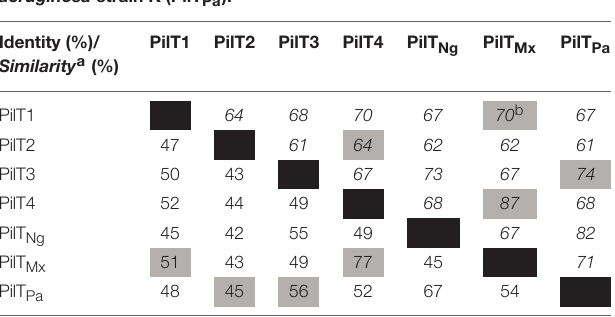
TABLE 3 | Identity and similarity of the putative PilT proteins of G. sulfurreducens (in red) in pairwise comparisons with each other and the